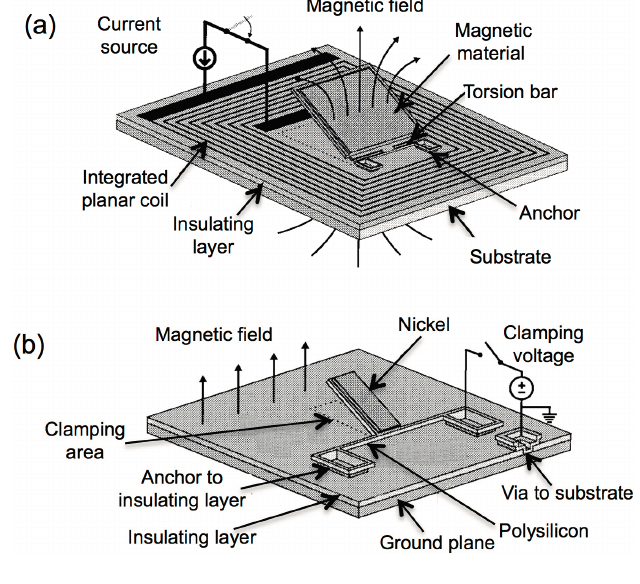
Figure 8. Scheme of potential microactuators employing ( a ) microfabricated coils for local magnetic actuation and ( b ) electrostatic clamping for latching the actuated state [130]. Reprinted with permission from [130]. Copyright 1997